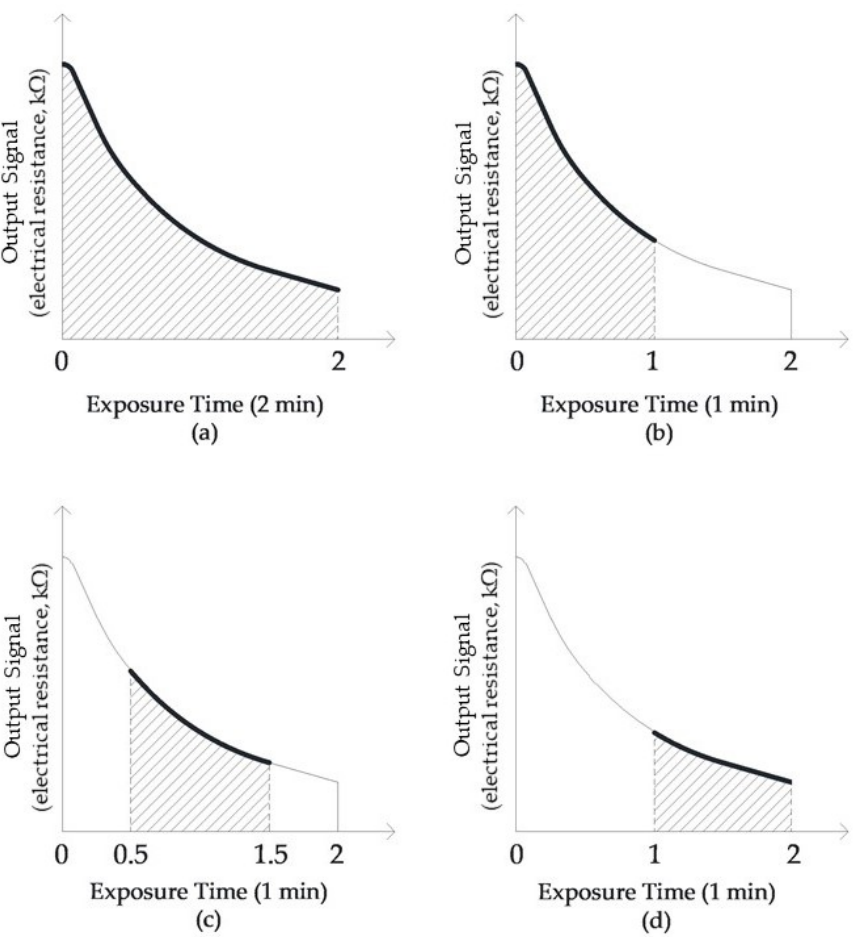
Figure 2. Extracted signals at different points ( a ) complete sensors response curve; ( b ) rise period; ( c ) intermediate period; ( d ) peak period.